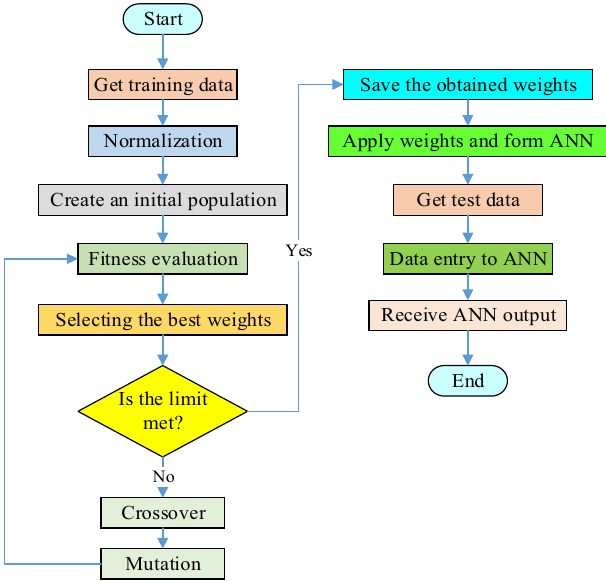
Figure 12. Flowchart of the proposed controller design.